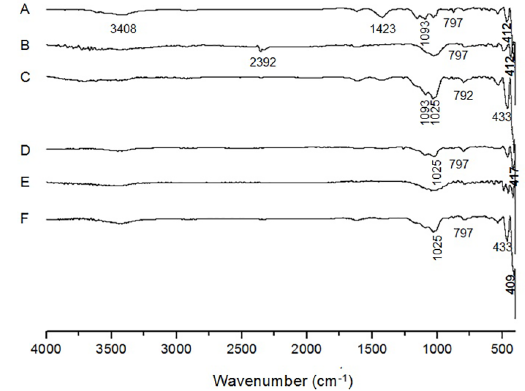
Figure 1. XRD of the samples treated in the CO pyrite; 2) pyrrhotite; 3) quartz.